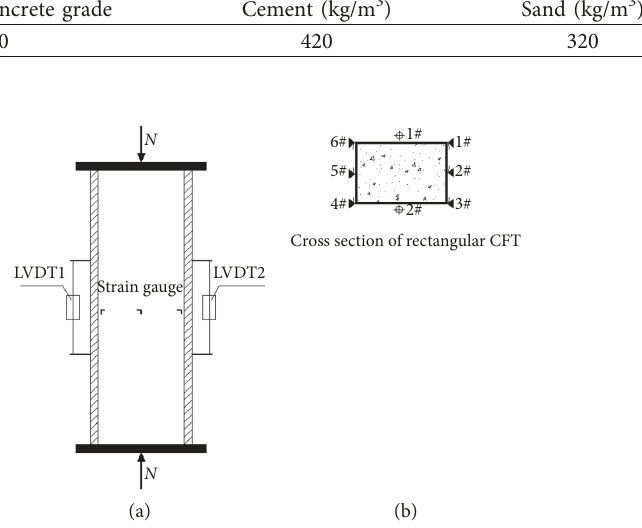
Figure 2: Test specimen and instrumentation.